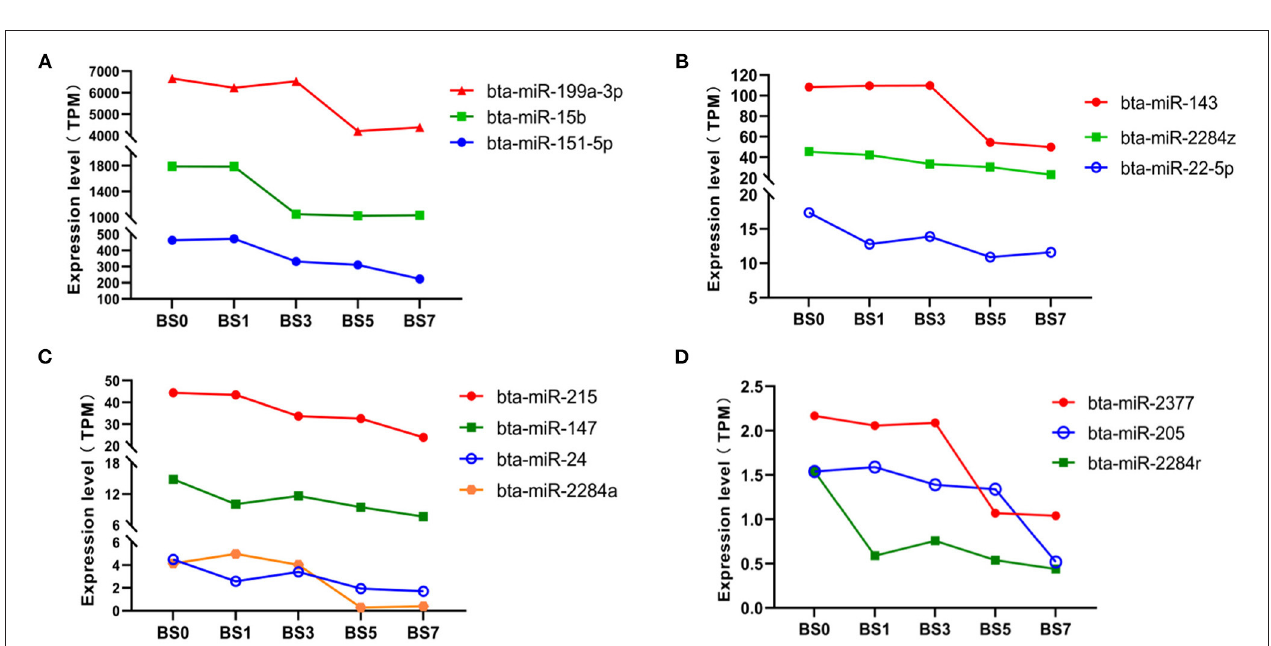
FIGURE 4 | Expression of miRNA with expression partially up-regulated at different induction times. (A) miRNA with highly abundant expression; (B) miRNA with medium and lowly abundant expression.